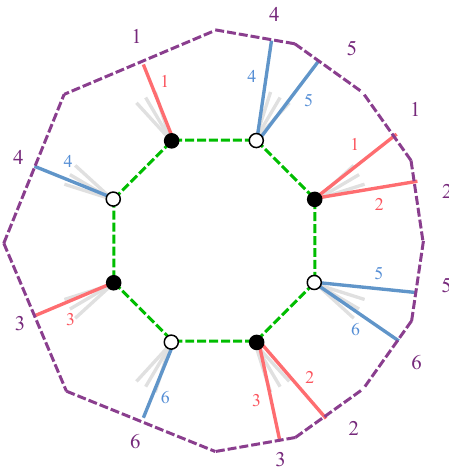
Figure 24. Change in the Riemann surface by gluing a (cid:1) g = k Figure 24 shows the change in the Riemann surface for k = 4. Figure 24 should be interpreted as follows.